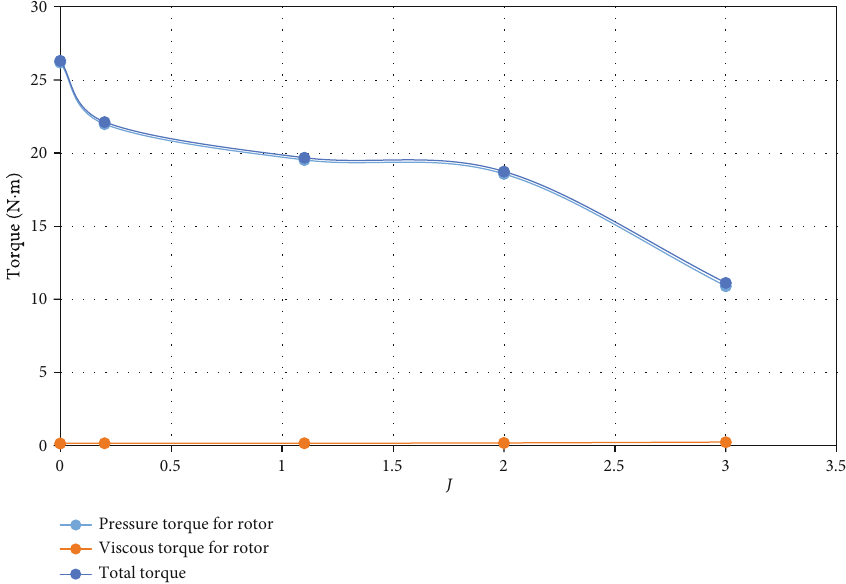
Figure 10: Torque force calculated for the linear jet system with a stator.